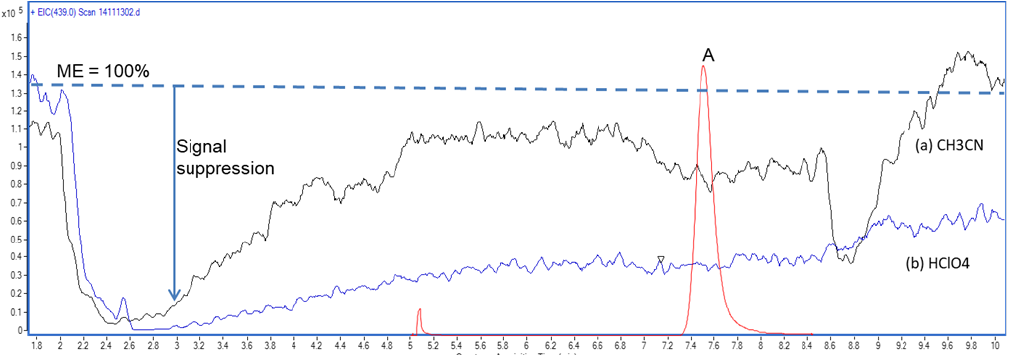
Figure 3. MEs evaluation by post-column infusion.